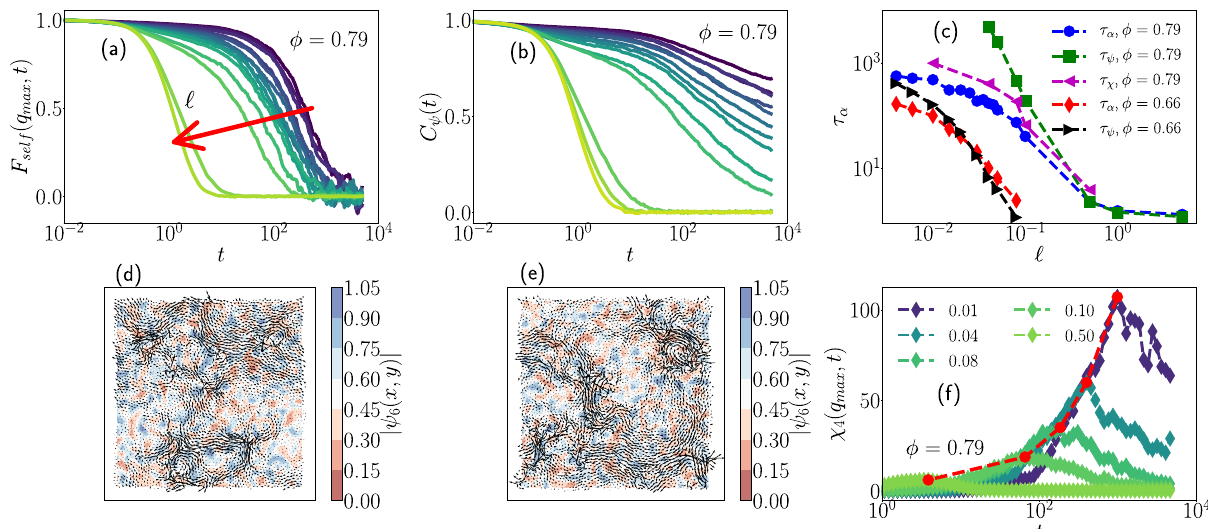
Fig. 5 Relaxation dynamics at high packing fraction fully polydisperse Active Brownian particles. a Intermediate scattering function F self ( q , t ) computed at the peak of the static structure factor q = q max . The red arrow indicates increasing values of ℓ = 0.004, 0.006, 0.01, 0.015, 0.02, 0.025, 0.03, 0.035, 0.04, 0.045, 0.05, 0.08, 0.1, 0.5, 1.0, 5.0 ( b ) Relaxation dynamics of the correlation C ψ ( t ). c Structural relaxation time obtained from the intermediate scattering function ( τ α ), from C ψ ( τ ψ ), and from the peak of the dynamical susceptibility ( τ χ ). Density fl uctuations decay faster than the orientational ones. The map of displacements on a time scale τ χ are shown in ( d ), and ( e ), for ℓ = 10 − 3 and 10 − 2 , respectively. The color map indicates the magnitude of the hexatic order fi eld ∣ ψ 6 ( x , y ) ∣ . The map reveals the presence of heterogeneous regions in both fi elds, long-time displacement and local hexatic order. f Dynamical susceptibility χ 4 ( t ) for different persistent lengths ℓ (see legend). The red circles indicate the peak position χ 4 ( τ χ ) ( τ χ is reported in ( c ) as a function of ℓ